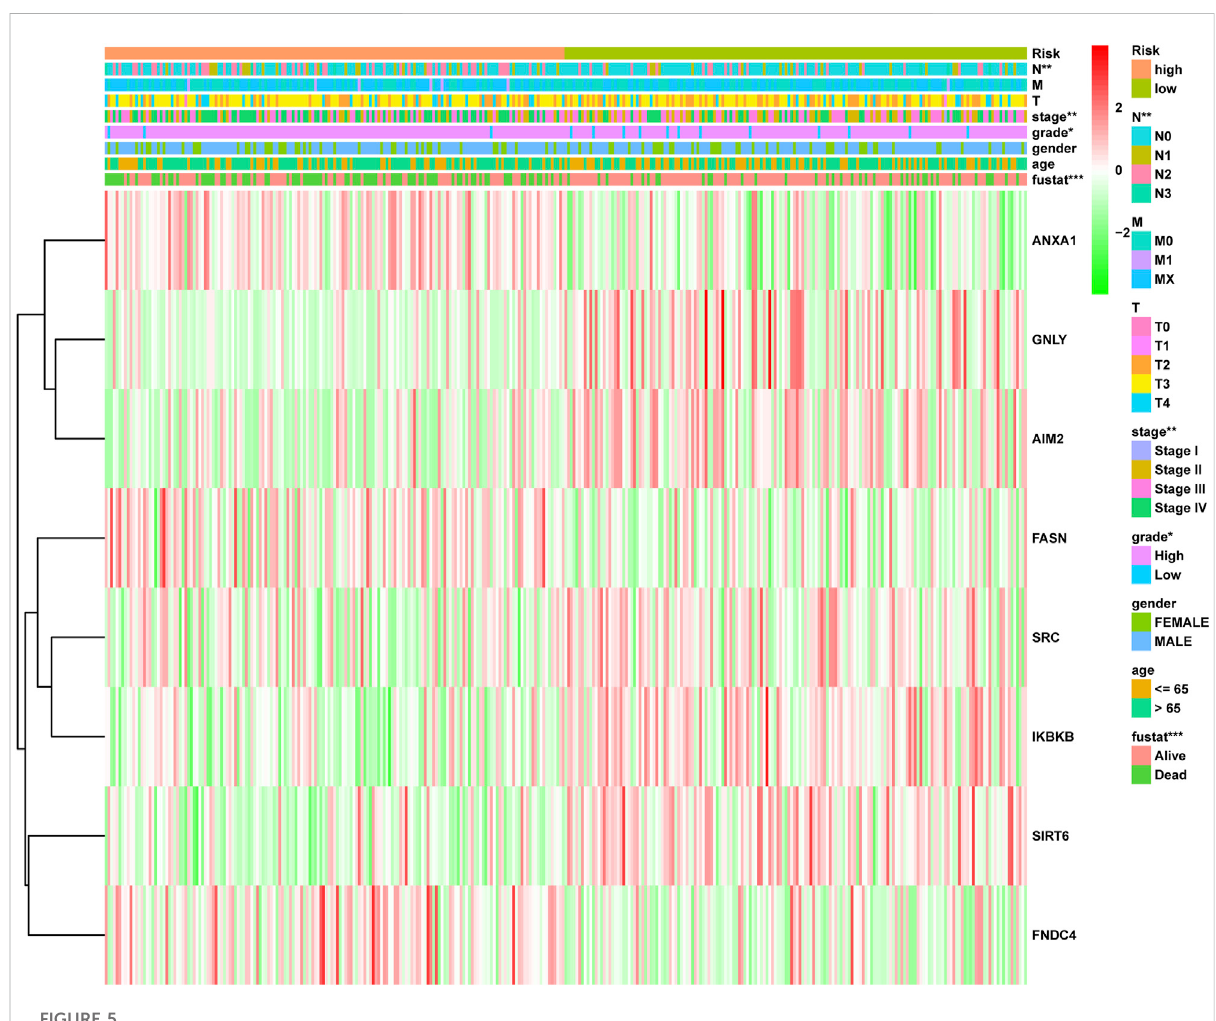
FIGURE 5 Distribution heatmap of NRG score and clinicopathological variables in the high- and low-risk groups. * p < 0.05, ** p < 0.01, *** p <